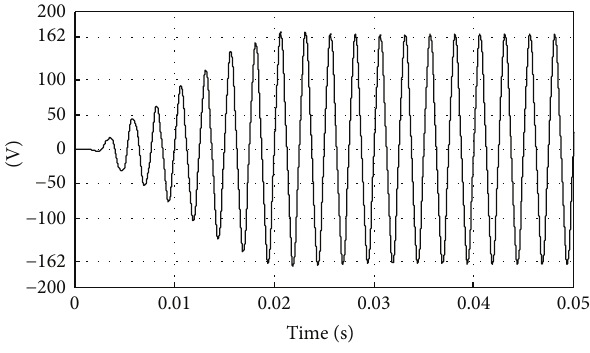
Figure 10: Simulation of